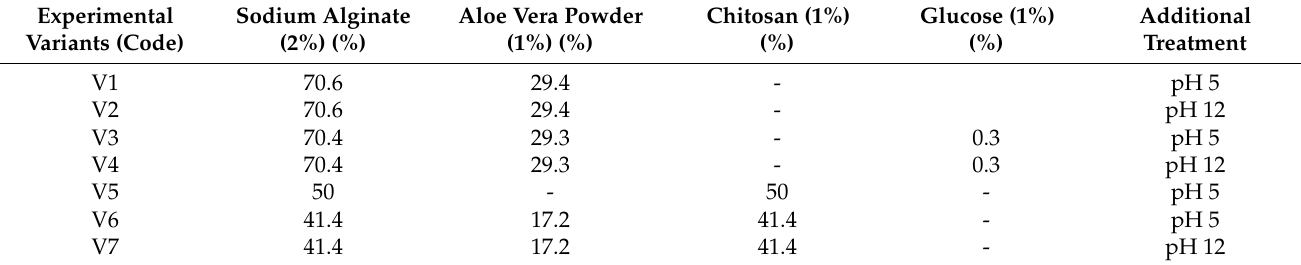
Table 1. The composition of obtained